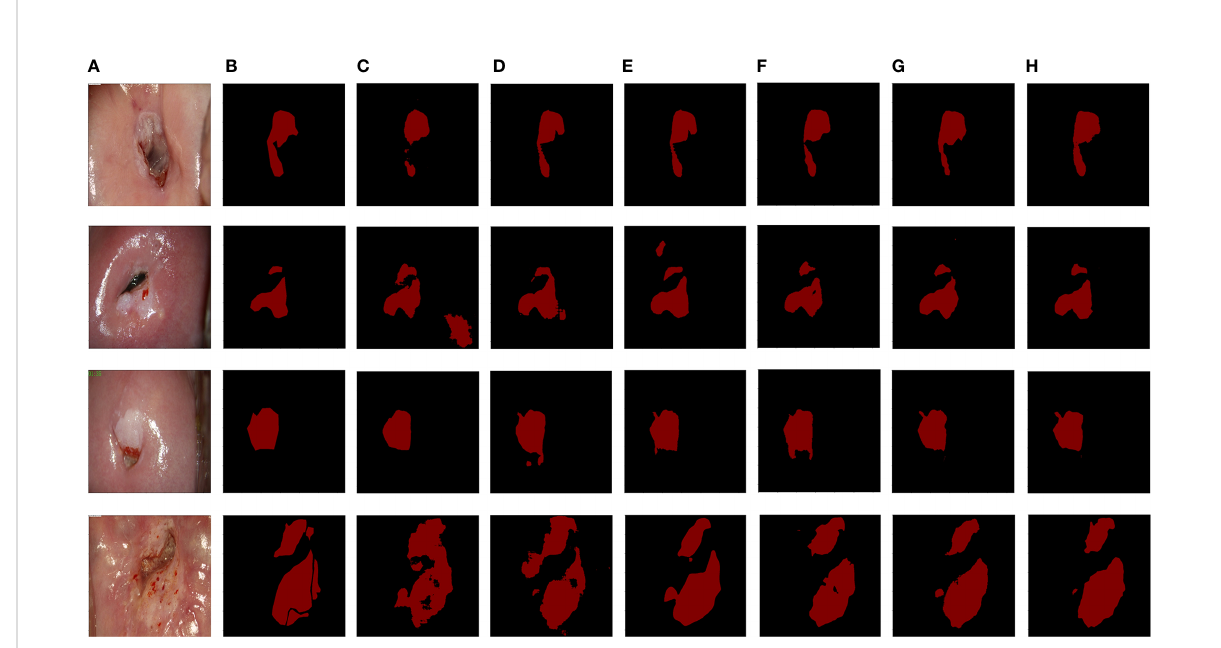
FIGURE 5 The segmentation results from six methods. (A) Original image. (B) Ground truth. (C) UNet. (D) FCN8x. (E) DeepLabV3+. (F) SegNet. (G) CCNet. (H) CLS-Net.